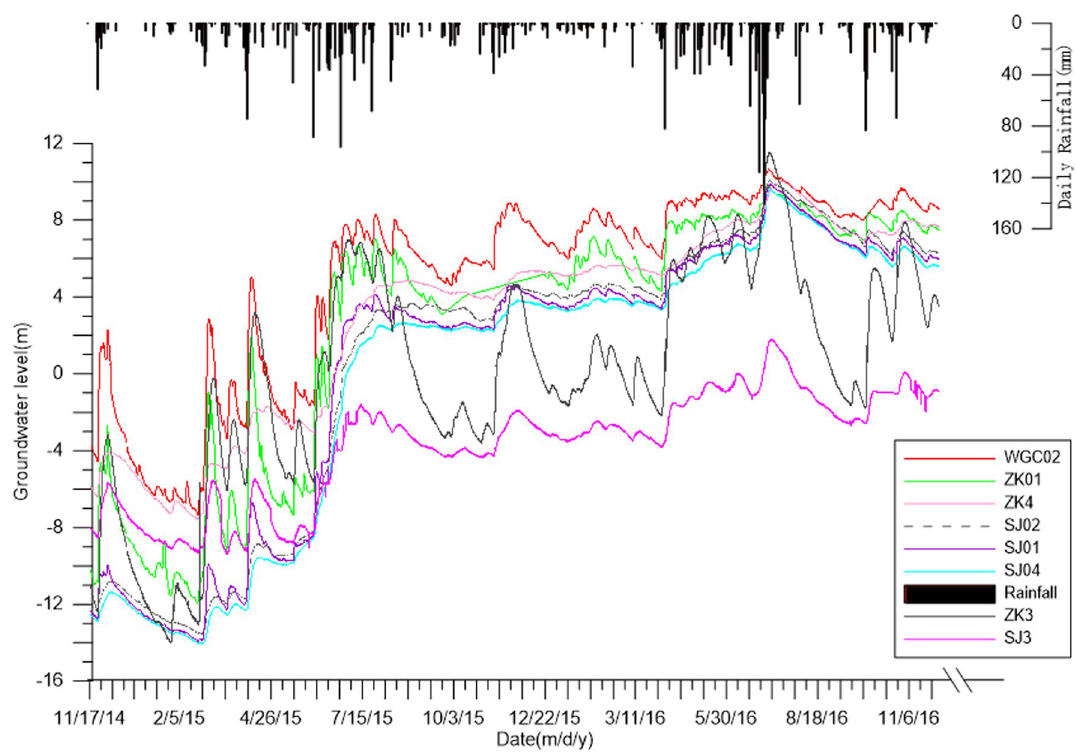
Fig. 7 Dynamic change of groundwater-gas pressure at monitoring wells on both sides of the groundwater